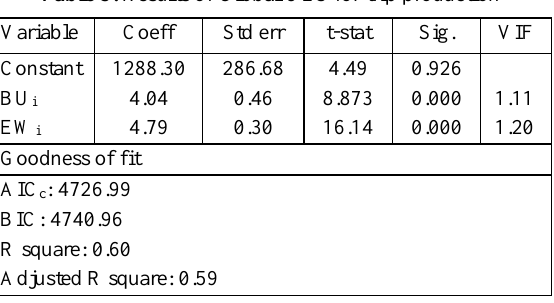
Table 4. Results of Global OLS for trip